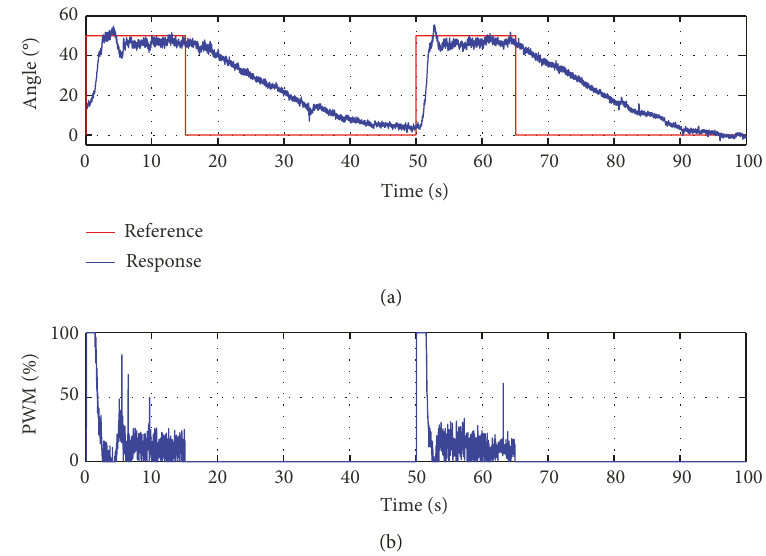
Figure 16: (a) Elbow exoskeleton transient response with step reference signal. (b) PWM control